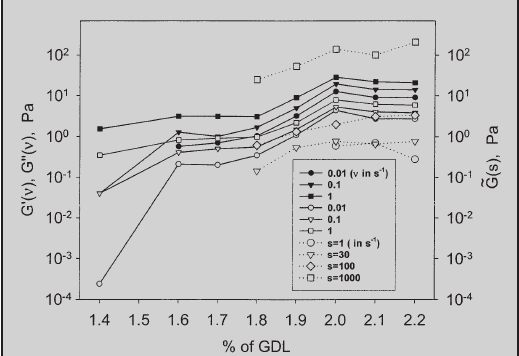
Figure 5 (right): The mechanically measured frequency dependent storage G’( ν ) (solid symbols) and loss G’’( ν ) (open sym- bols) moduli at different frequencies ν and the viscoelastic modulus calculated from the optical data (large open symbols) at different values of Laplace frequency s plotted against the starting concentrations of